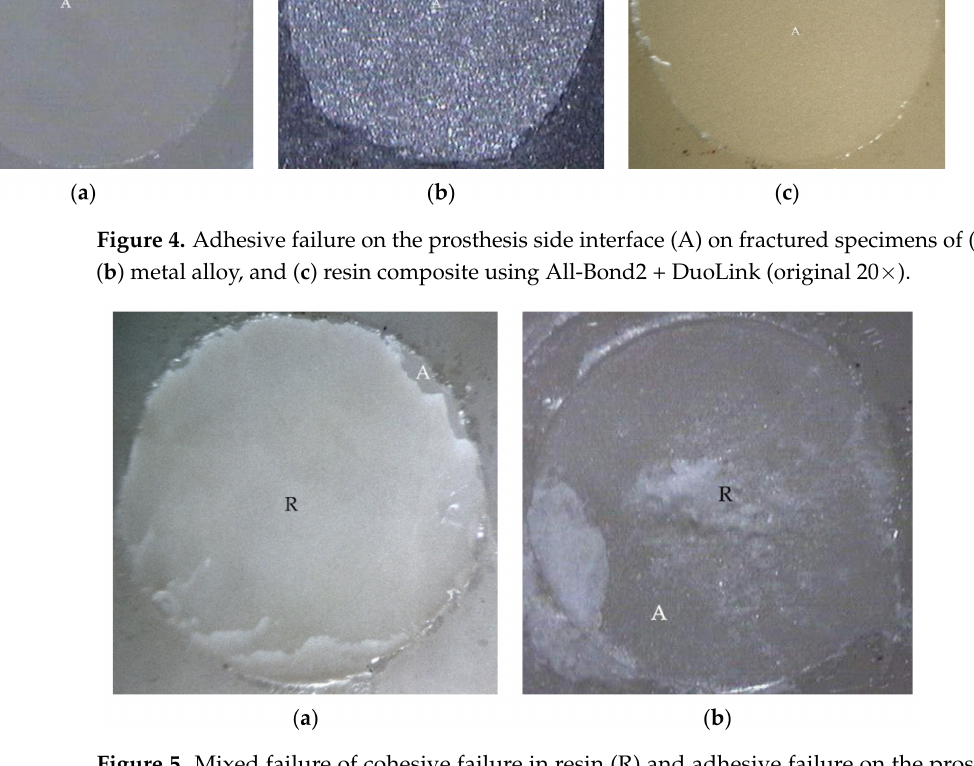
Figure 5. Mixed failure of cohesive failure in resin (R) and adhesive failure on the prosthesis side interface (A) on fractured specimens of ( a ) experimental biopolymer bonded with All-Bond2 + DuoLink and ( b ) ceramic bonded with Super-Bond (original 20 ×